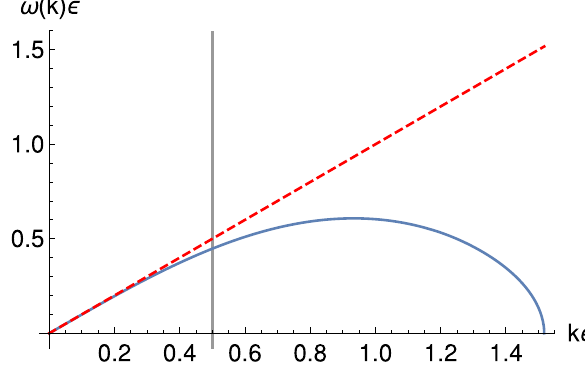
Fig. 2 Comparison of the two dispersion relations: the classical one (red, dashed) and the modified one (blue, solid) given by (25). The ver- tical solid line denotes the maximal observable mode k max = 10 3 k ∗ (with k ∗ the pivot mode corresponding to 0 . 002 Mpc − 1 today), under the choices (cid:2) = 0 . 5 / k max = 0 . 015 and β = 0 . 2375 and with infla- tion driven by a scalar field with mass m = 1 . 3 × 10 − 6 and value φ(η ) = 3 . 13 at the beginning of inflation ( d φ/ dt | η o